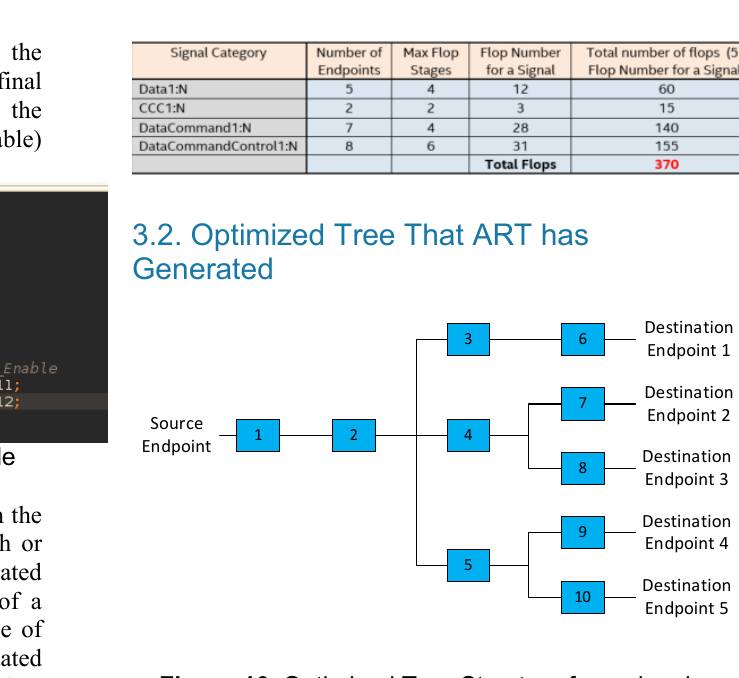
Figure 10. Optimized Tree Structure for a signal category